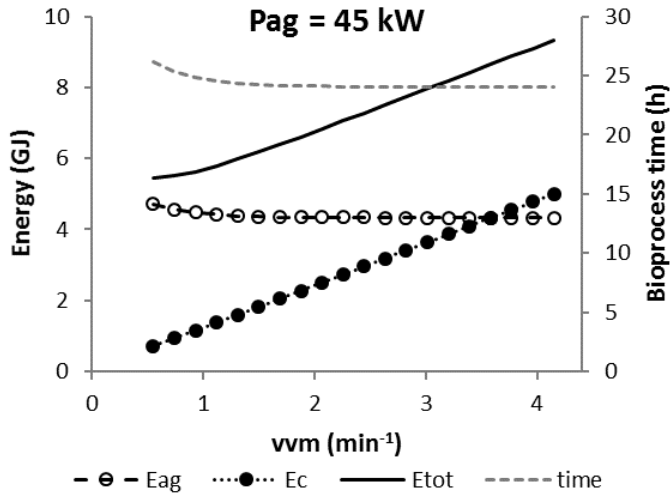
Figure 3. Scenario K: Influence of vvm on agitator ( Eag ), compressor ( Ec ) and total ( Etot ) electric energies and bioprocess time for Pag = 45 kW.